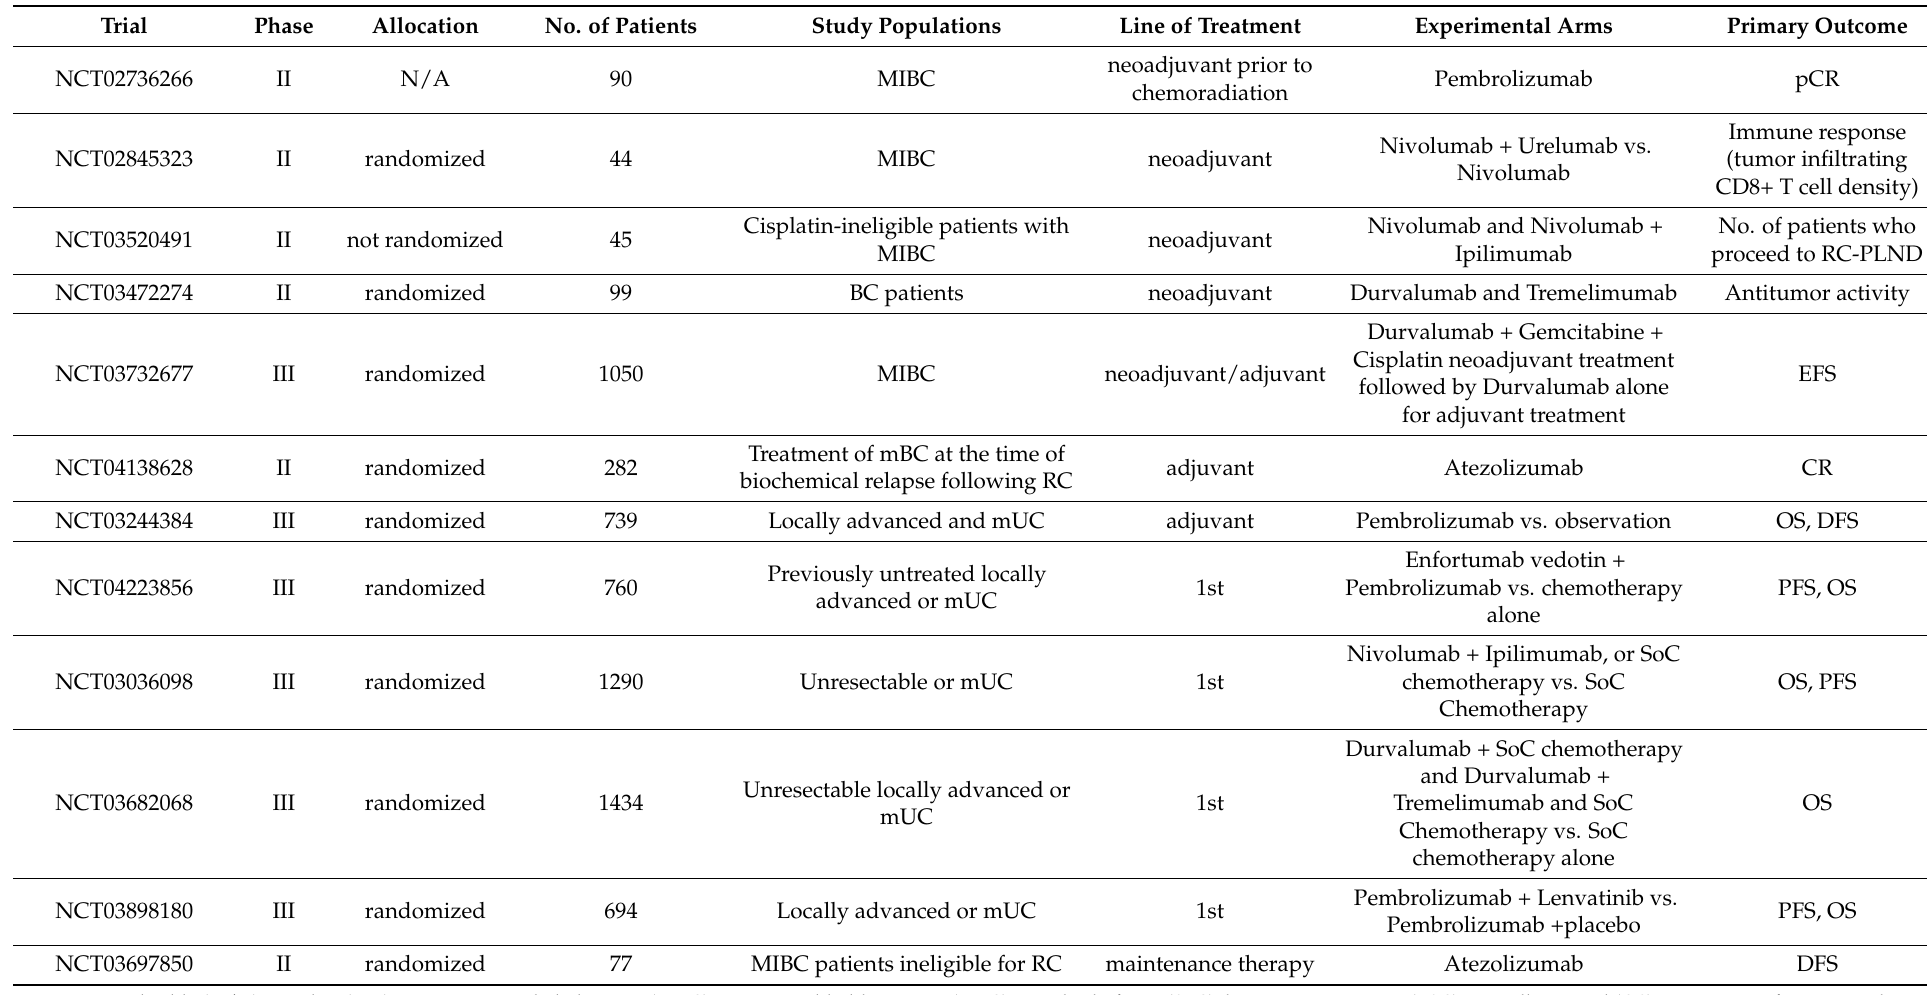
Table 2. Ongoing phase II/III trials with active recruitment on ICIs alone or in combination with chemotherapy in different settings of BC treatment. Trial Phase Allocation No. of